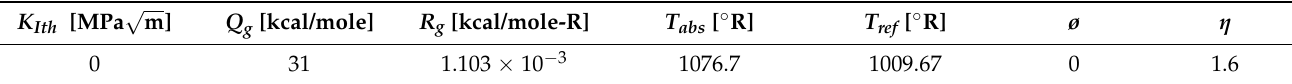
Table 6. Parameters of SCC growth.